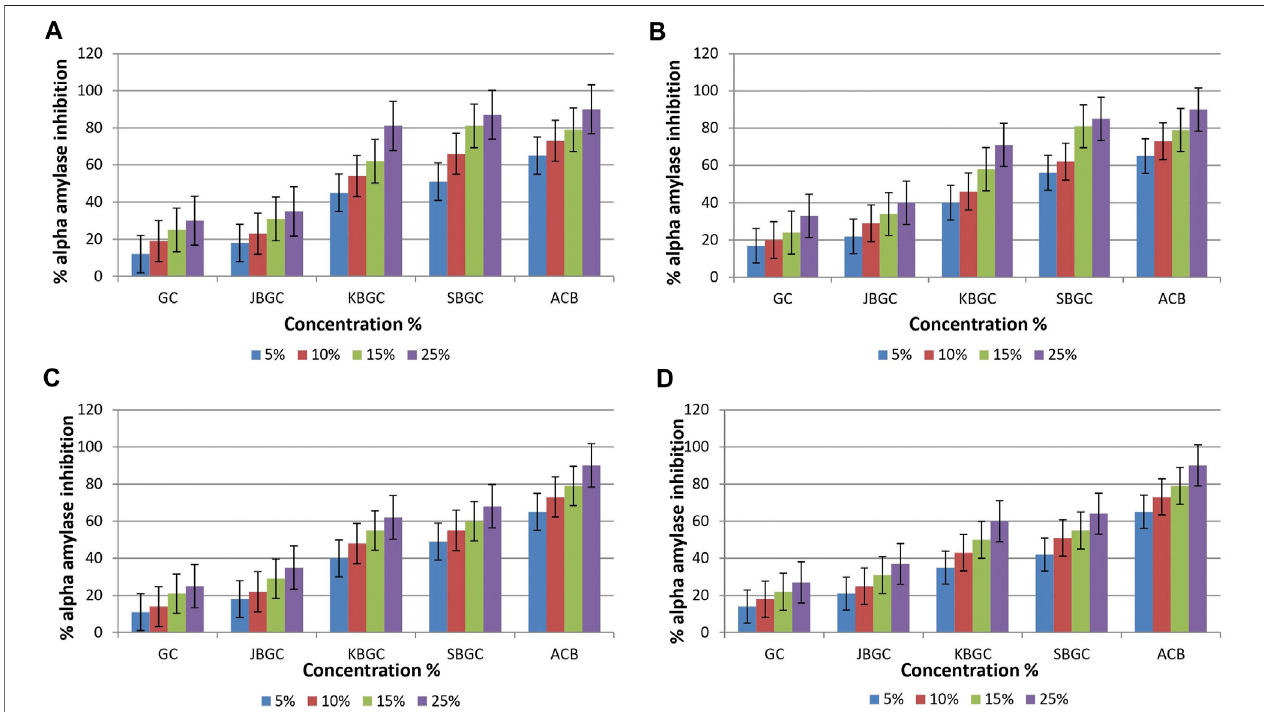
FIGURE 2 | α -amylase inhibitory activity of Guduchi Churna (GC), Svarasa Bhavita Guduchi Churna (SBGC), Kwatha Bhavita Guduchi Churna (KBGC), and Jala Bhavita Guduchi Churna (JBGC). (A) In phosphate buffer solution (PBS) (B) In dichloro methane (DCM) (C) In chloroform (D) In